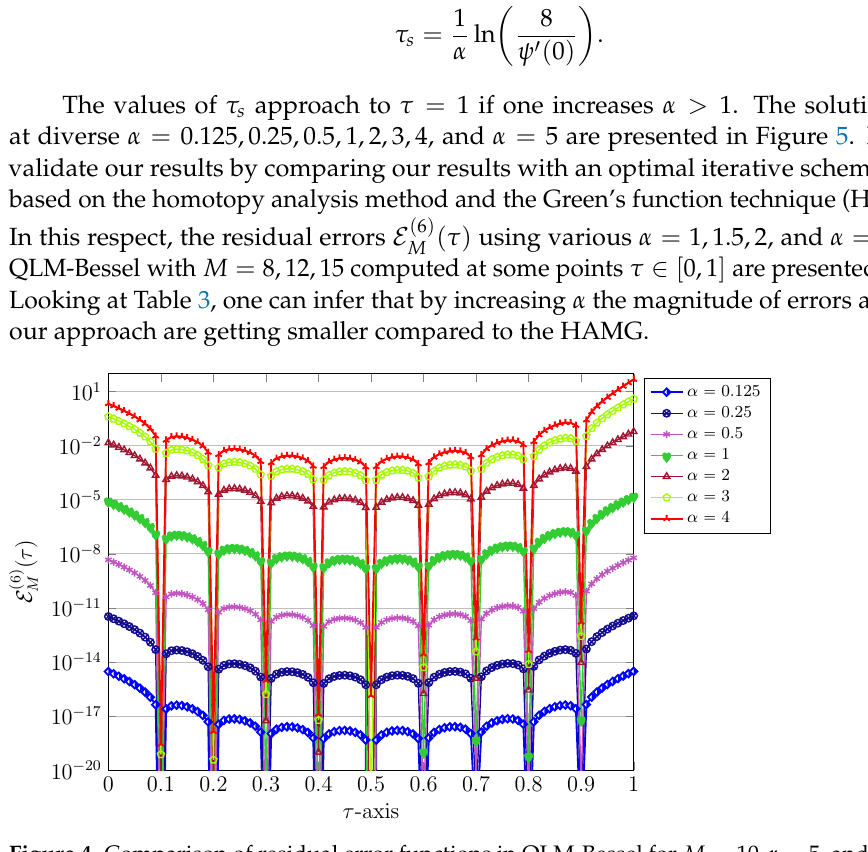
Figure 4. Comparison of residual error functions in QLM-Bessel for M = 10, r = 5, and various α